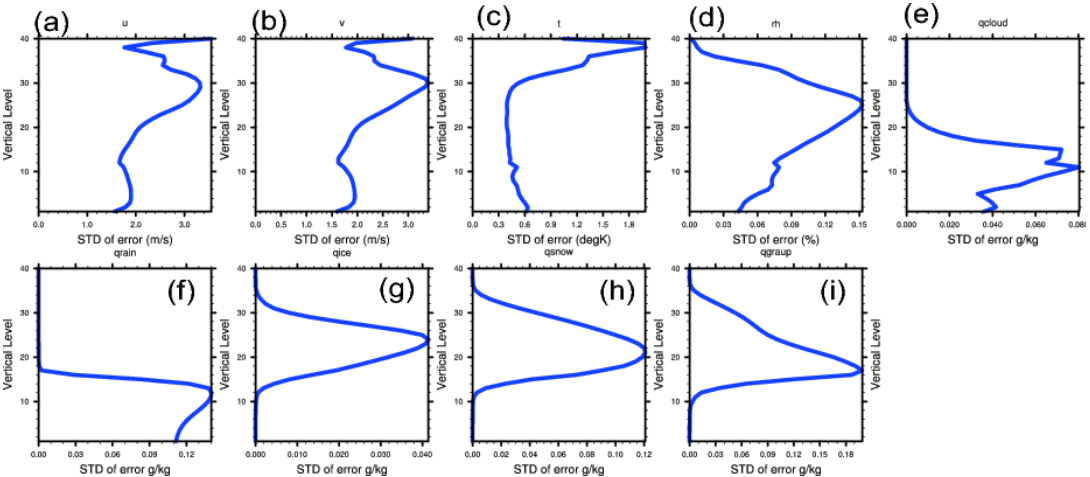
Figure 3. The standard deviations of the background errors at different vertical levels for ( a ) zonal wind (u-wind), ( b ) meridional (v-wind), ( c ) t—temperature, ( d ) rh—relative humidity, mixing ratio